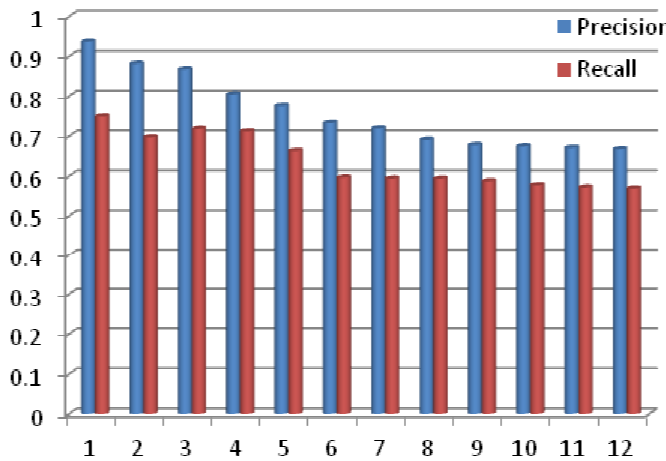
Figure 6. Precision and Recall of CAME for match making vs. number of performed